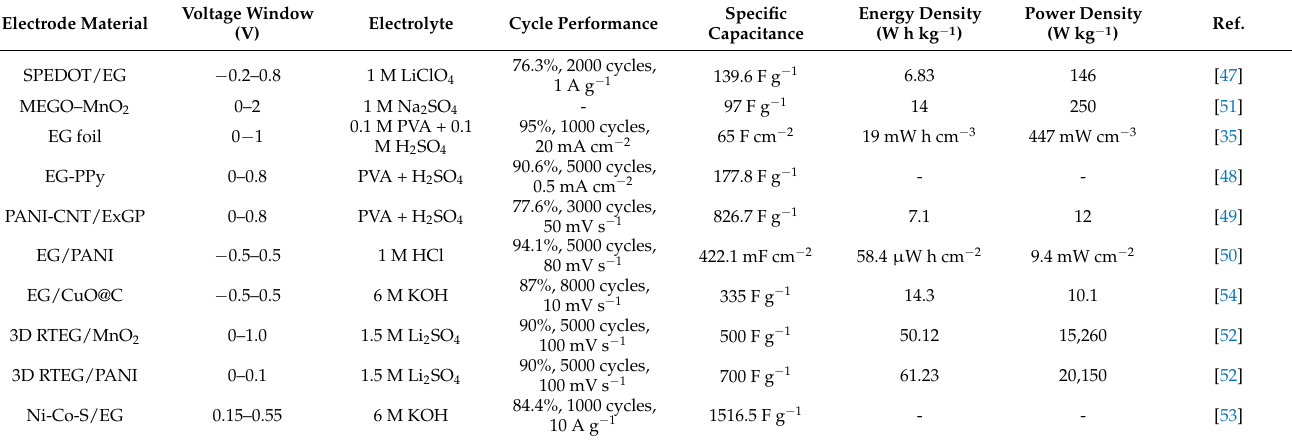
Figure 6. ( a ) Schematic illustration of the fabrication process of EG foil; ( b ) SEM of EG foil; ( c – f ) Electrochemical properties of solid flexible supercapacitors based on EG foil [35]. Reprinted with permission from Reference [35]. Copyright 2017 Elsevier. Table 1. Summary of symmetric supercapacitor using EG-based materials as electrode materials.